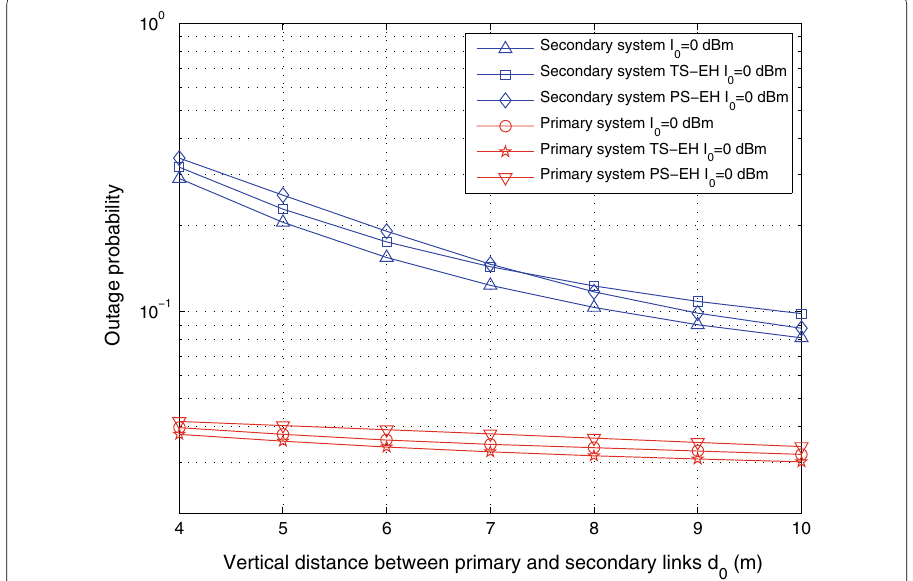
Fig. 6 Outage probability versus the vertical distance between primary and secondary links d